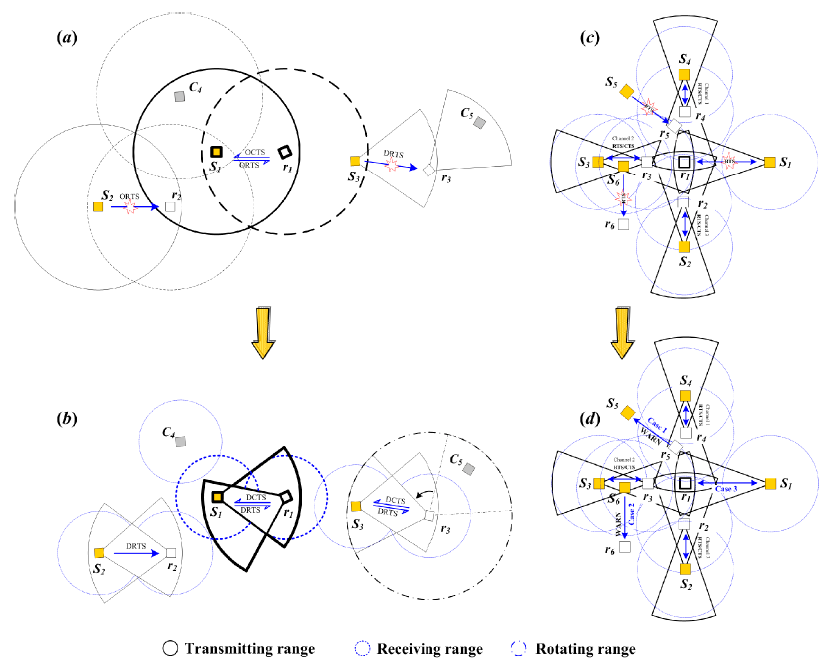
Figure 6. Potential problematic scenarios in DDC-MAC. ( a ) problematic scenario of deafness and hidden terminal problem; ( b ) solutions of deafness and hidden terminal problem by DDC-MAC; ( c ) problematic scenario of interference and congestion problem; ( d ) solutions of interference and congestion problem by DDC-MAC.